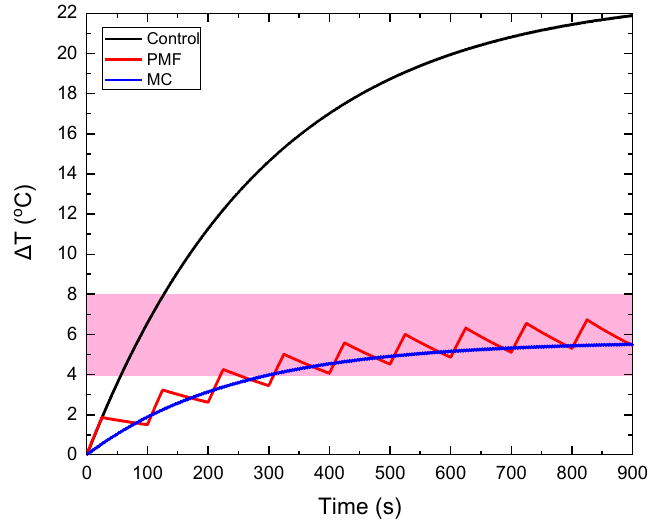
Figure 3. Illustration of the feasibility of our method. The control ∆ T curve corresponds to the classical MPH method and is compared to the ∆ T curves obtained from MC and PMF methods under 8 cm maximum coil displacement and 25% Duty Cycle, respectively. The magnetic field at the measuring point of temperature was equal to 60 mT, as shown by the field simulations of Figure S2a in the Supplementary Materials. All ∆ T curves correspond to the CTP